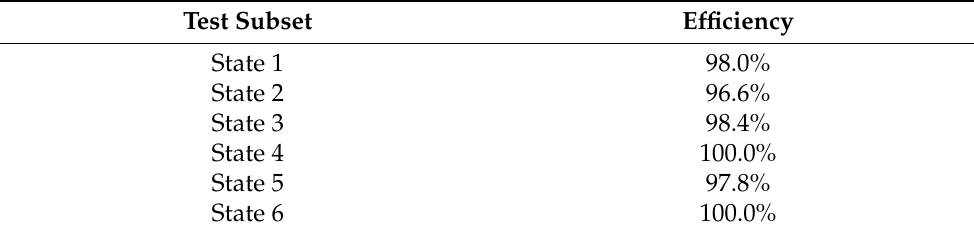
Table 3. Efficiency of NET1_HF neural network in each of 6 data sets.